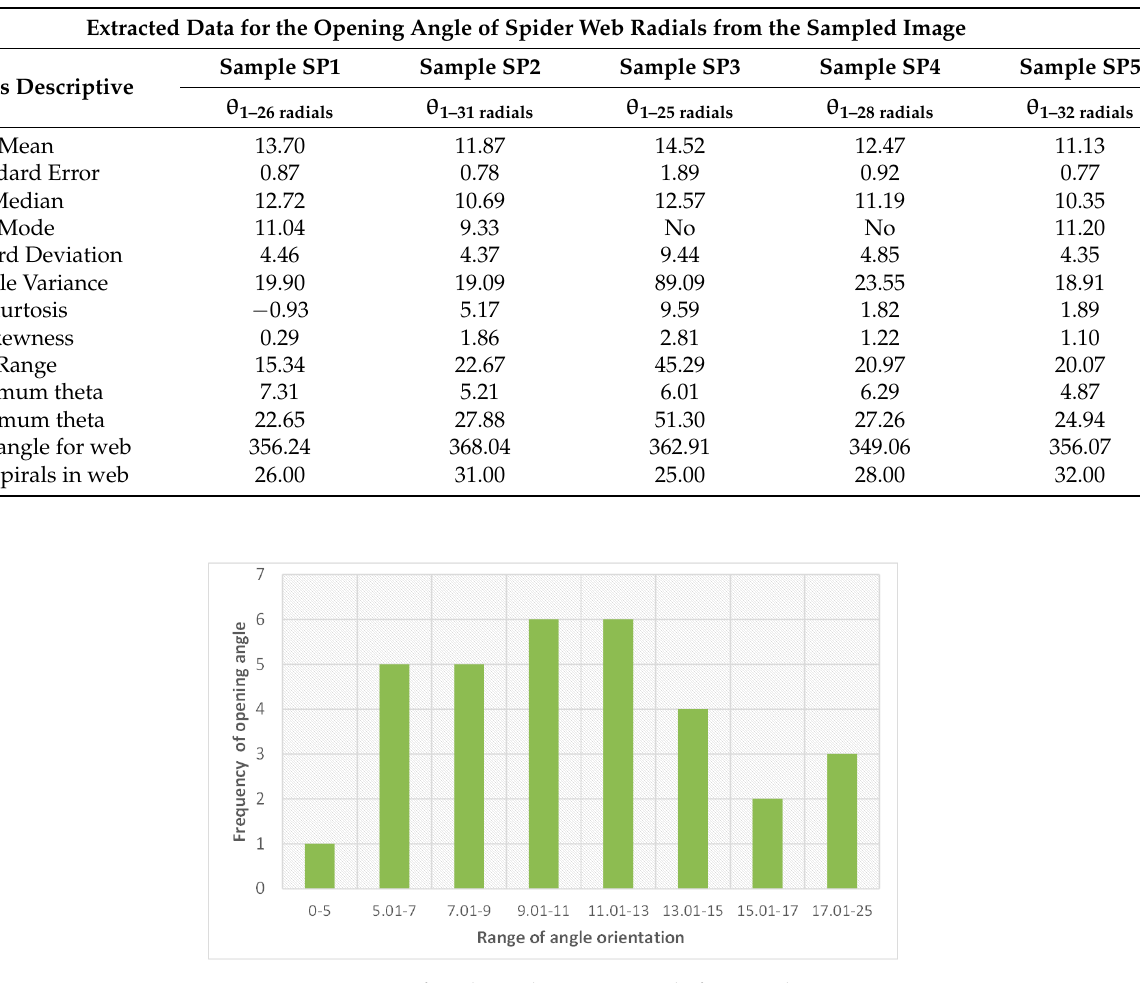
Extracted Data for the Opening Angle of Spider Web Radials from the Sampled Image